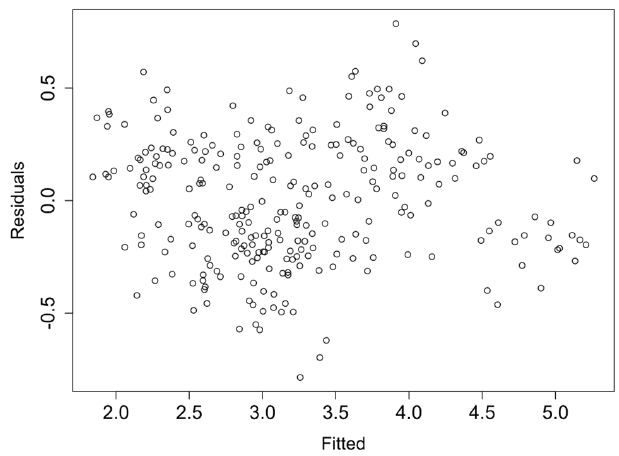
Figure 13. Fitted vs. residual values—Group 1.